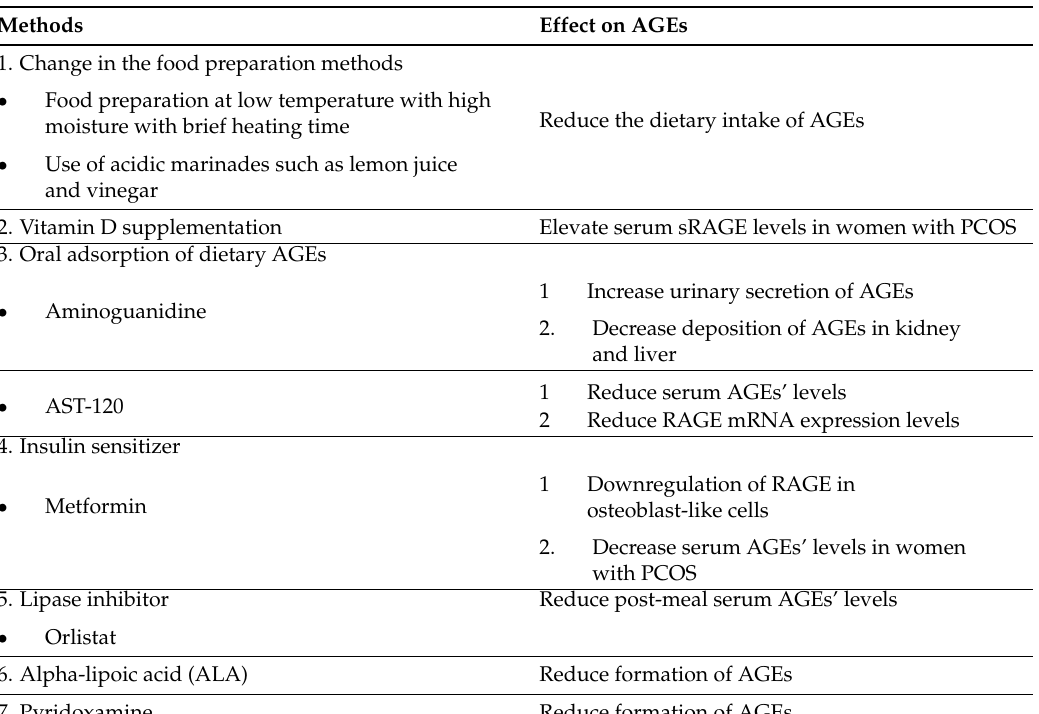
Table 2. Methods for attenuating the effect of